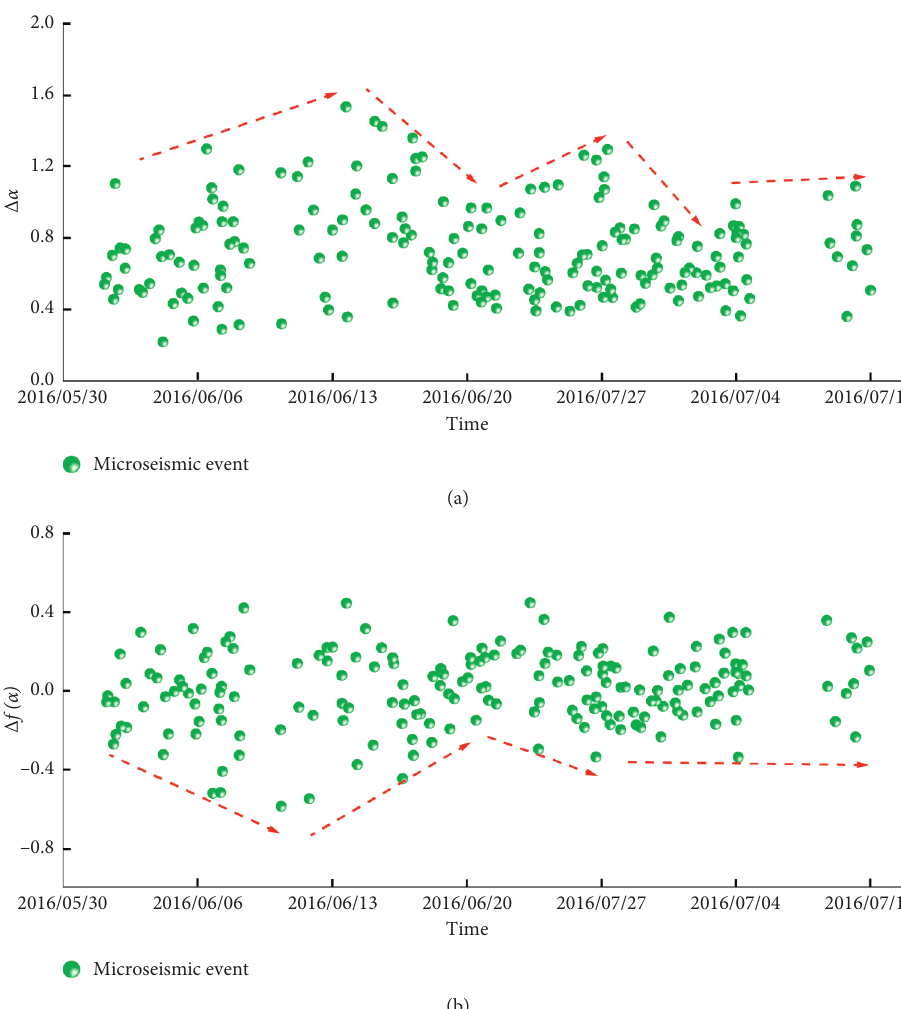
Figure 15: Evolution characteristics of multifractal spectrum parameters vs. time: (a) Δ α characteristics with time; (b) Δ f ( α ) characteristics with time.